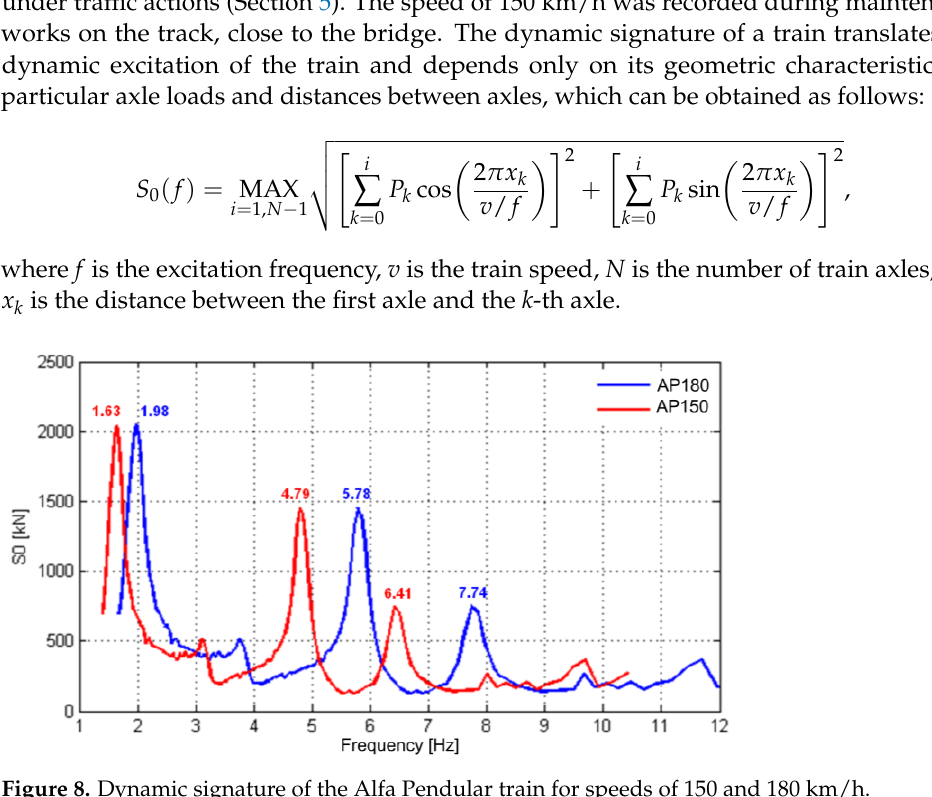
Figure 8. Dynamic signature of the Alfa Pendular train for speeds of 150 and 180 km/h.